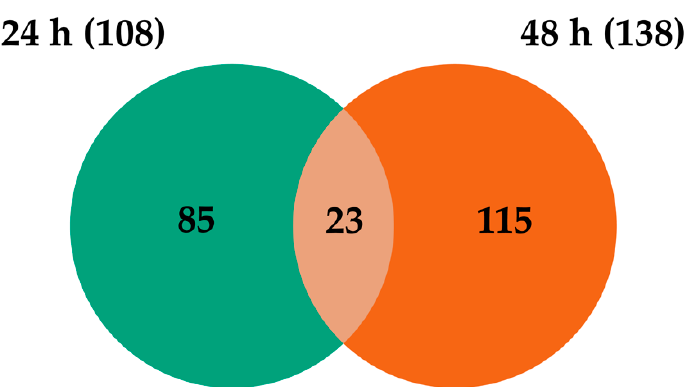
Figure 4. Venn diagram representing the number of differentially expressed transcripts at the different time points post-infection with WNV. Table 1. List of Ae. albopictus overlapping differentially expressed transcripts following WNV infection. Functional categories are based on GO terms for biological processes. The cut-offs used were p -adjusted value of ≤ 0.01 and log 2 FC of ≥ 0.5.